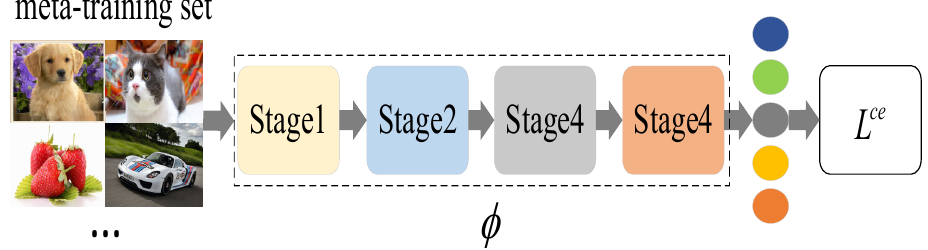
Figure 3. Schematic diagram of embedding model training in adaptive feature fusion method. Training the embedding model φ using the merged meta-training set. Stage l represents each stage of the embedded model structure.